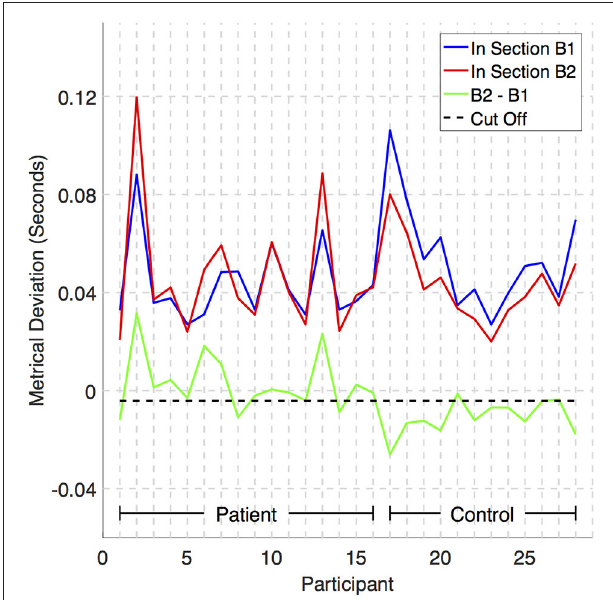
FIGURE 6 | A plot of mean metrical deviations against participant. Mean metrical deviation MD_m is the mean of the absolute deviations between each played note onset and the time of the closest underlying beat. The blue line is MD_m for section B1, the red line is MD_m for section B2, the green line is the difference MD_m_B2 − MD_m_B1, and the black horizontal line indicates a cut off that discriminates between most BPD patients and